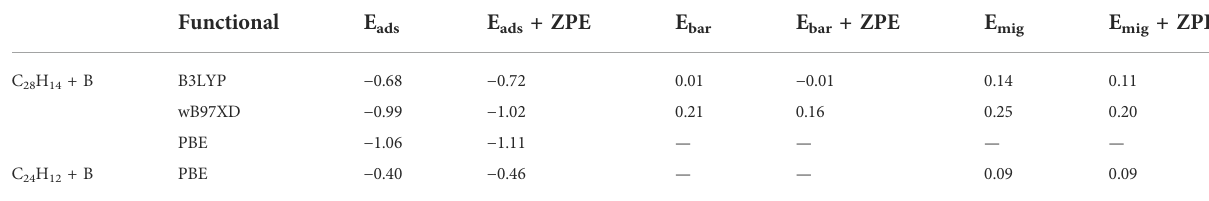
TABLE 3 Adsorption energies (E ads ), barriers to adsorption (E bar ), and barriers to migration (E mig ) calculated with and without zero-point energy corrections for each of the DFT functionals investigated. Functional E ads E ads + ZPE E bar E bar + ZPE E mig E mig + ZPE C 28 H 14 + B B3LYP − 0.68 − 0.72 0.01 — — — — C 24 H 12 + B PBE − 0.40 − 0.46 —